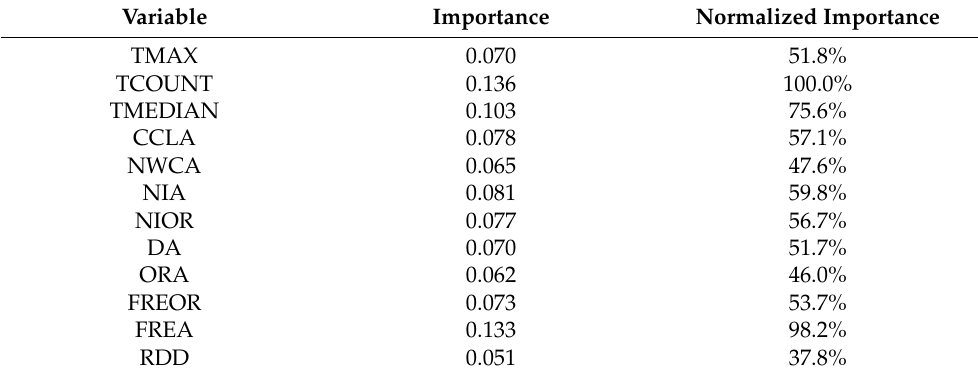
Table A2. Overview of independent variable importance in the neural networks.